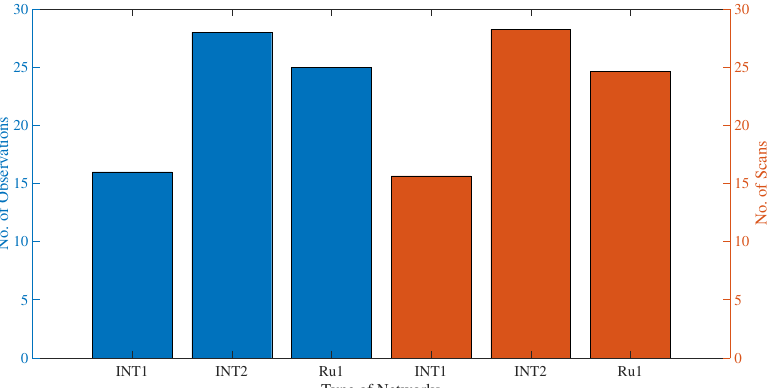
Figure 3. The number of VLBI observations and scans during the CONT17 campaign for Intensive sessions. The y -axis ( left ) represents number of observations, and the y -axis ( right ) represents number of